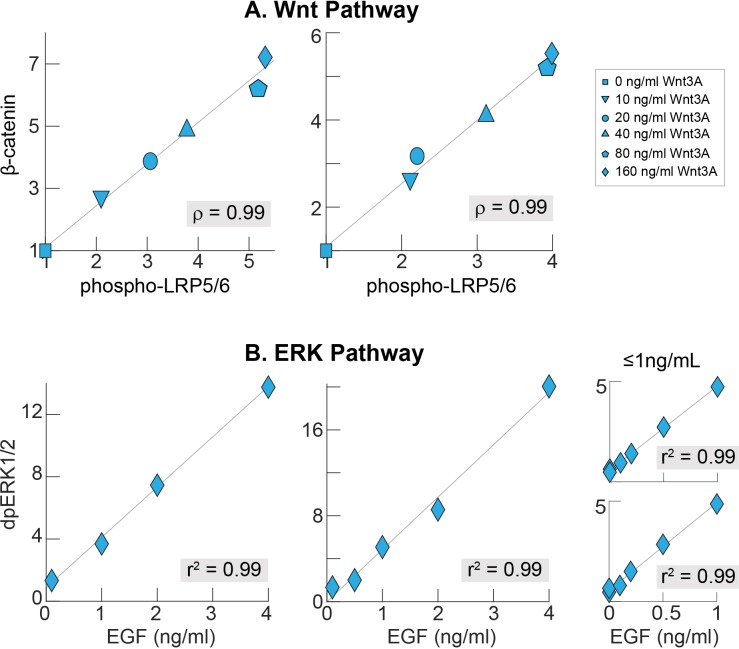
Linearity was observed across independent experiments.(A) In these two independent experiments, RKO cells were stimulated with a range of Wnt3A doses, lysed after 6 hr, and analyzed for Western blot against β-catenin and phospho-LRP5/6. (B) In these four independent experiments, H1299 cells were stimulated with a range of EGF doses, lysed after 5 min, and analyzed for Western blot against doubly-phosphorylated ERK. All measurements are plotted relative to unstimulated cells. Grey lines are least squares regression, ρ is Pearson correlation coefficient, and r2 is correlation coefficient.